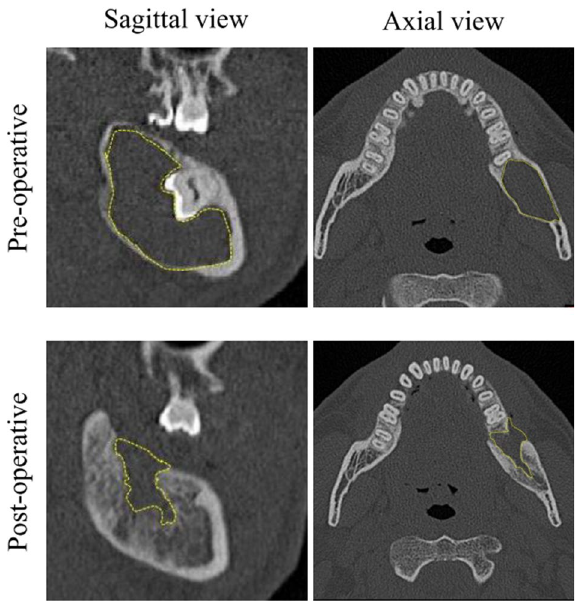
Figure 1. 3D measurement protocol by using computed tomography. After a ROI was delineated in one section, the border of the defects (yellow dotted line) was automatically generated for each slice on the axial and sagittal views, respectively. The defect volume was calculated through 3D